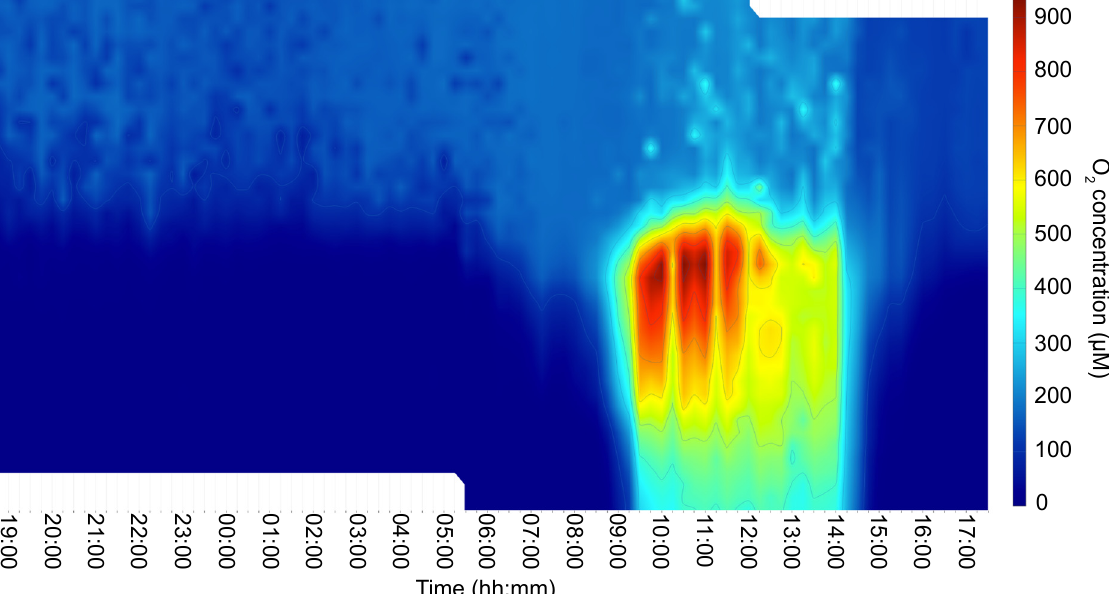
Figure 2. A heat map of the vertical O 2 concentration profiles in the cyanobacteria-dominated microbial mat of Nakabusa Hot Springs as measured over a diel cycle. The O 2 concentration ( µ mol L − 1 ) was measured as a function of depth in the microbial mat at 15-min intervals for 24 h from 18:00 on 3 November to 18:00 on 4 November. The mat surface is indicated by 0 mm. Positive depth values indicate the depth below the mat surface, and negative values indicate the depth above the mat surface, i.e., the distance into the overlying water column of the hot